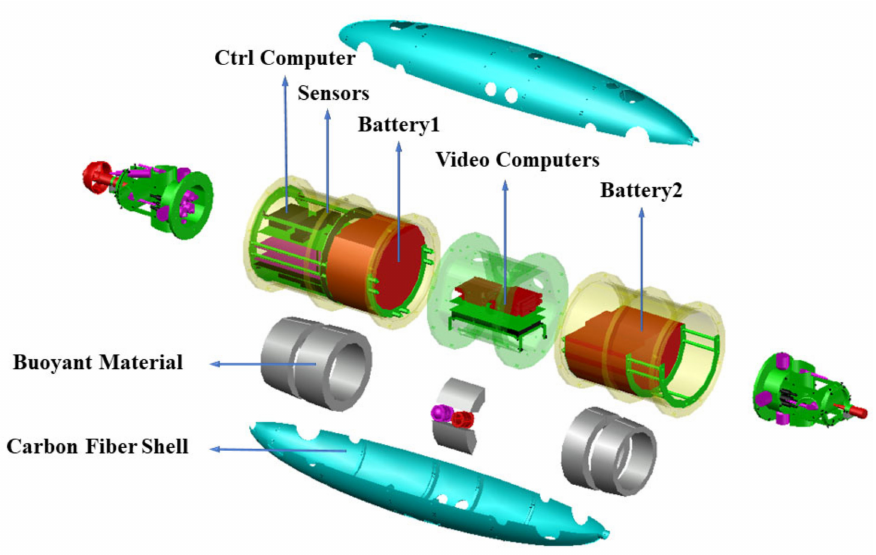
Figure 5. Energy and power system of the AUV-T.